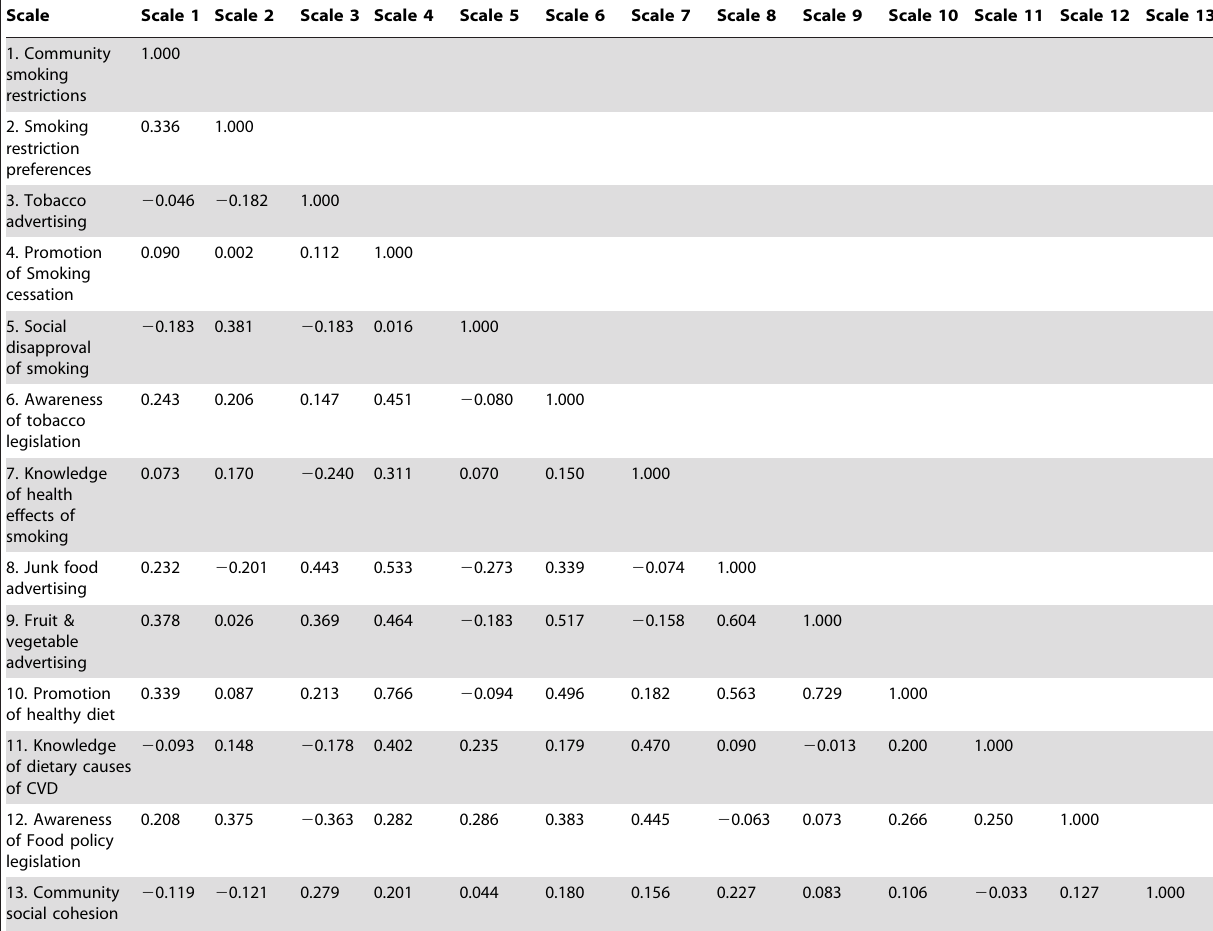
Table 3. Correlation matrix of scales measuring characteristics of the community